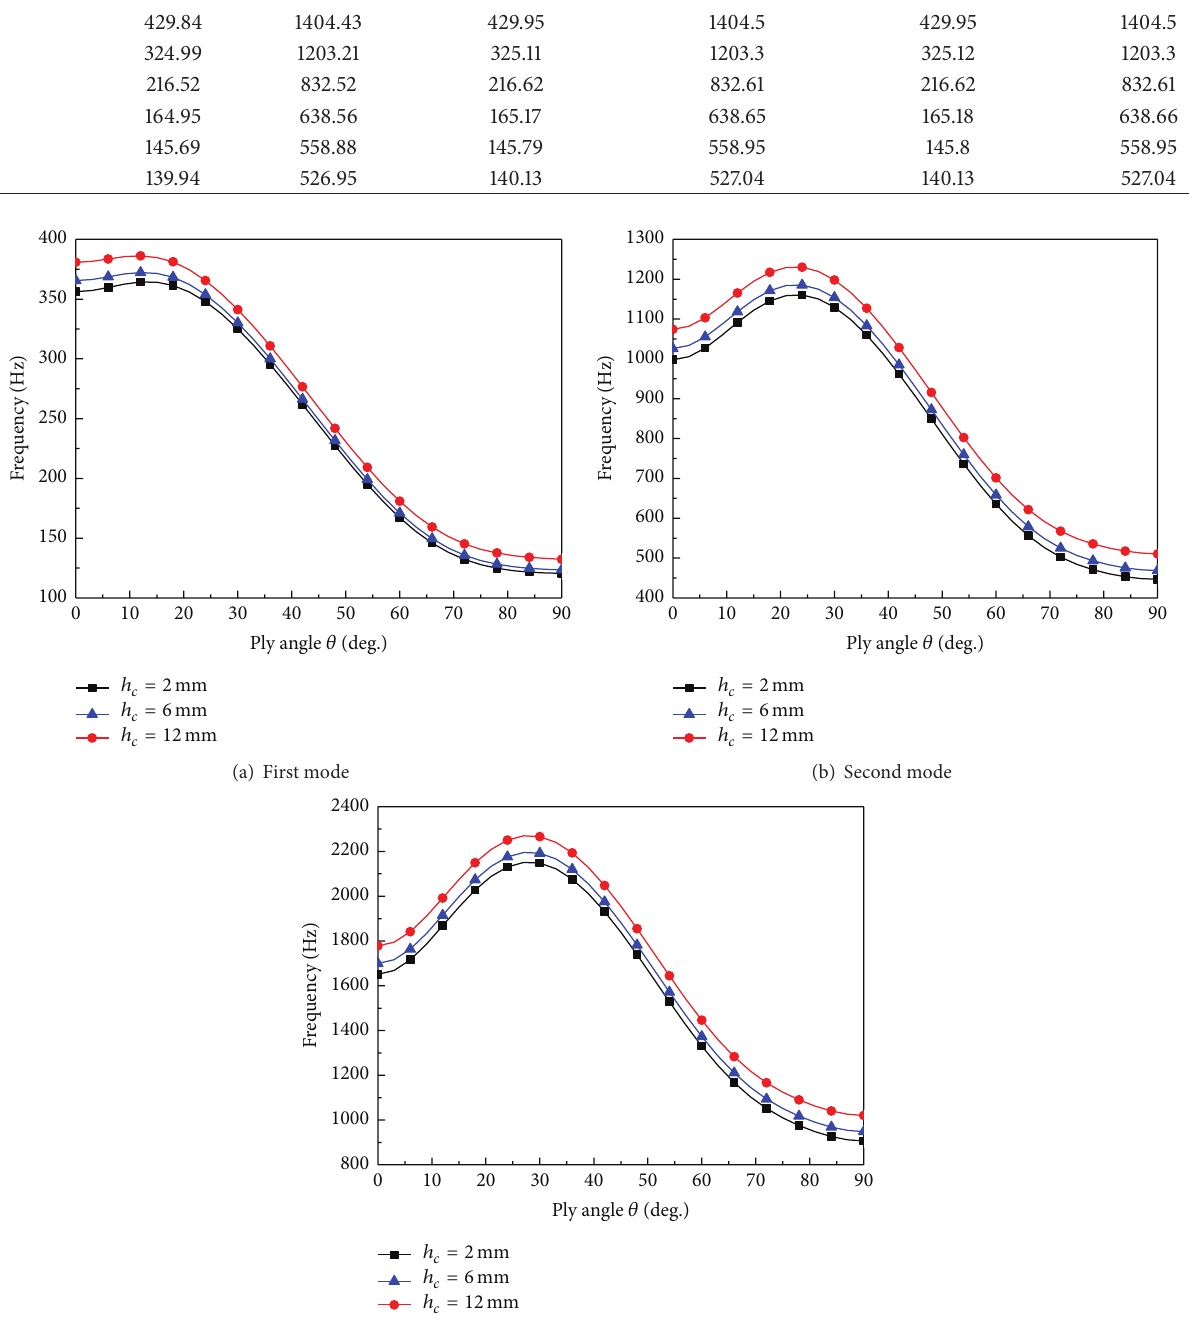
Figure 2: The first three natural frequencies versus fiber angle for various thicknesses of constraining layer ( ℎ V = 2 mm, Ω =